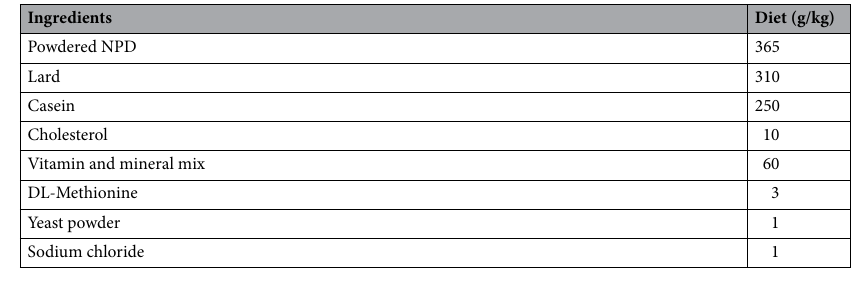
Table 1. High fat diet